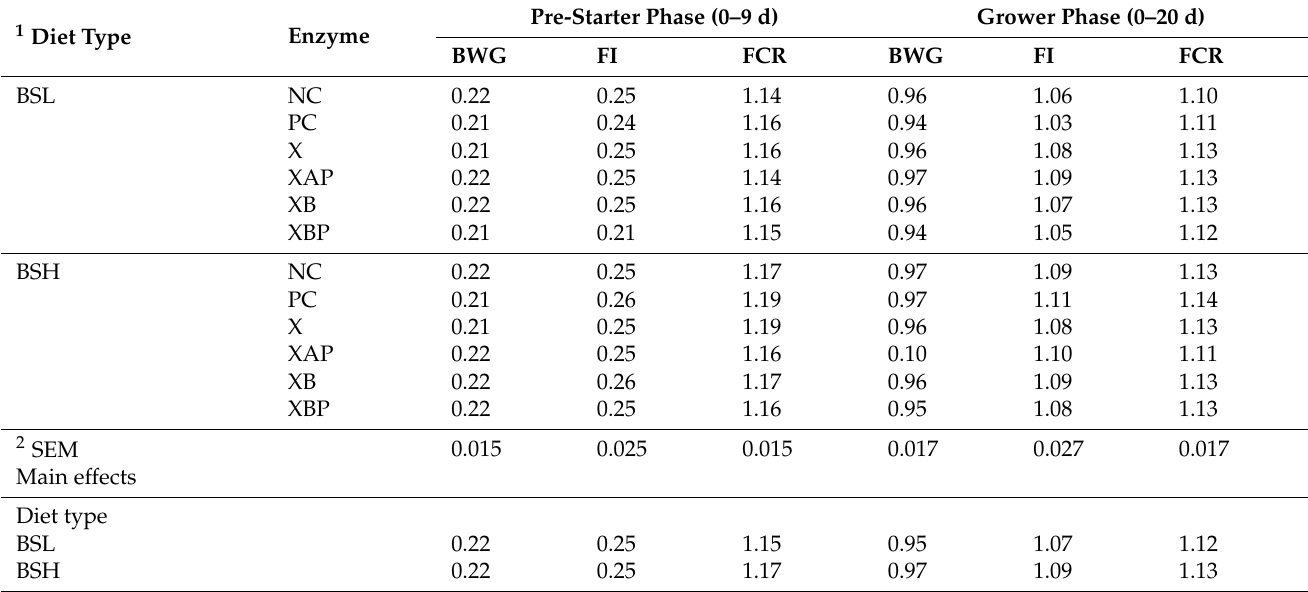
Table 5. Cumulative growth performance for broiler’s fed SFM-based diets with different exogenous enzymes from pre-starter and grower phase; BW (kg), FI (kg), FCR